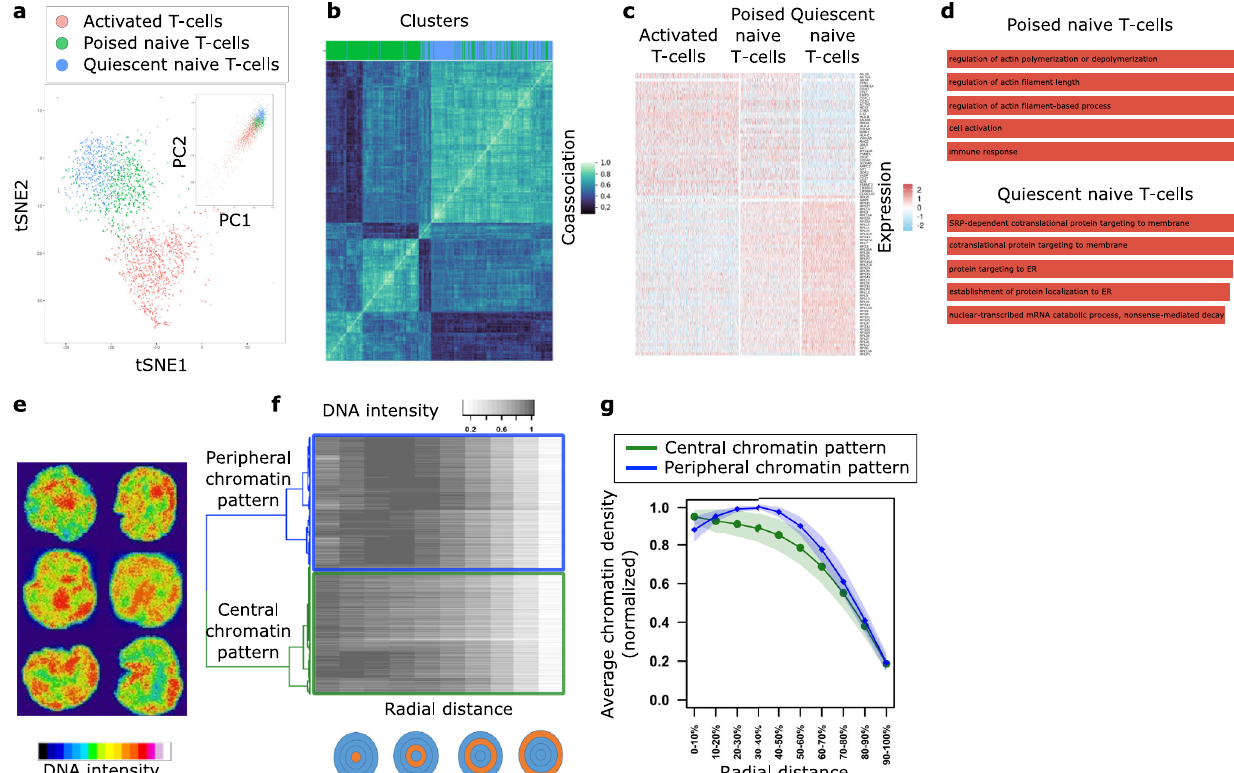
Fig. 3 Analysis of single-cell RNA-seq data and single-cell chromatin images of naive CD4 + T-cells reveals two distinct subpopulations respectively. a t-SNE and PCA (inset) embeddings of single-cell RNA-seq data derived from 31 . Cluster analysis reveals activated (red) population of T-cells and naive population of T-cells divided into two subpopulations (poised and quiescent, denoted in green and blue, respectively). b Consensus clustering plot demonstrating the robustness of quiescent (blue) and poised (green) clusters of naive T-cells to various clustering methods. Gene expression data was clustered using k-means, Gaussian mixture models, and spectral clustering based on a k-nearest neighbor graph with k ∈ {10, 20, 50, 100} with 100 initializations for each method. c Differential gene expression analysis between the blue and green subpopulations reveals two distinct gene expression programs. The green subpopulation of naive T-cells is more similar to the activated T-cells and hence poised for activation, while the blue subpopulation shows an upregulation of ribosomal genes and has a relatively more quiescent expression pro fi le. d Gene ontology enrichment analysis of marker genes for quiescent and poised naive T-cell subpopulations supports two distinct gene expression programs. e Examples of DAPI-stained nuclear images of naive CD4 + T-cells. f Cluster analysis of the 3D nuclear images is performed by fi rst quantifying the chromatin signal in concentric spheres with increasing radii, and then using hierarchical clustering on these spatial chromatin features. The features were clustered using hierarchical clustering with complete linkage based on the distance matrix obtained from 1-Spearman ’ s correlation. g Average chromatin signal, calculated using n = 729 cells from two biologically independent replicates, (mean represented by the solid line and standard deviation represented by shading) in concentric spheres with increasing radii for central (green) and peripheral (blue) clusters. One cluster has higher concentration of chromatin in the central region of the nucleus (green), while the other cluster has higher concentration of chromatin in the peripheral region of the nucleus